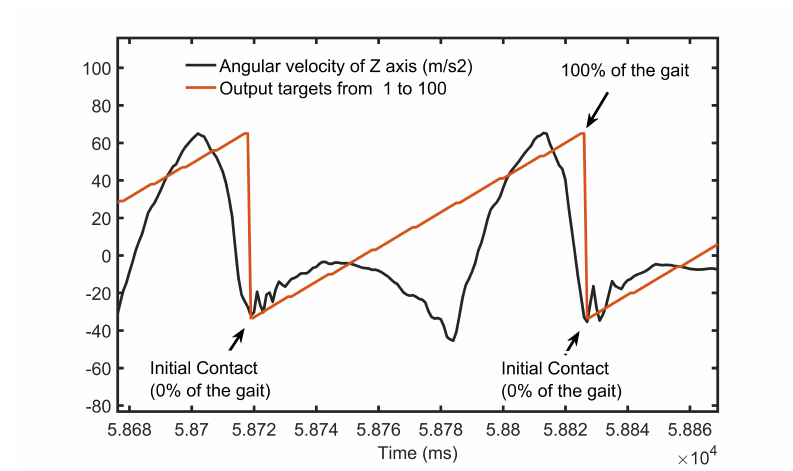
Figure 6. The figure shows one gait cycle discretised with a 1% interval. The division was based on measuring cycle latency, from an initial-contact (IC) at 0% to the next at 100%.